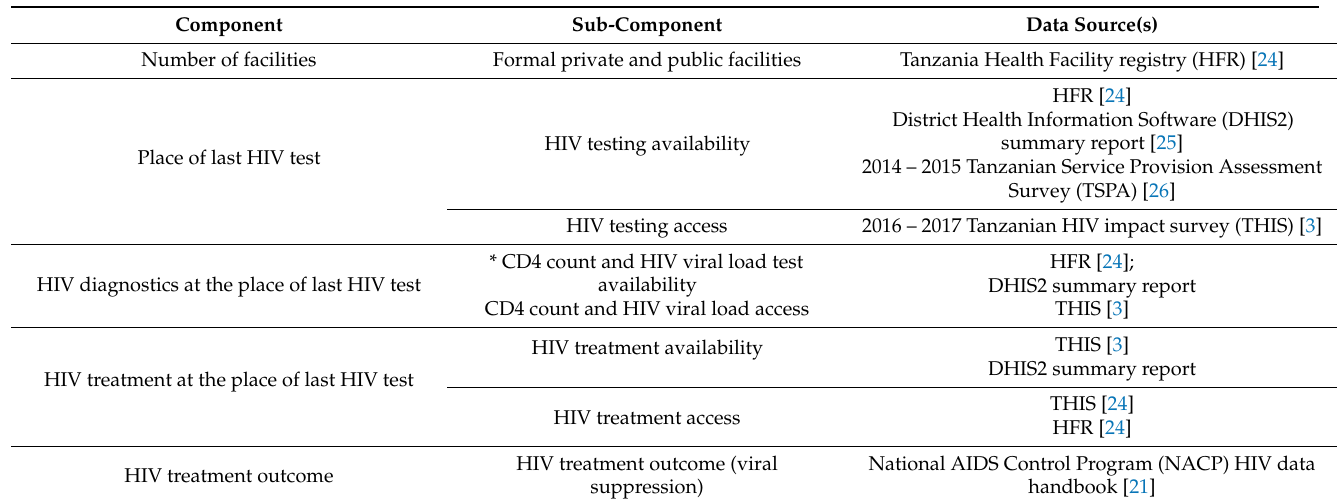
Table 1. Primary data sources for the PPA.